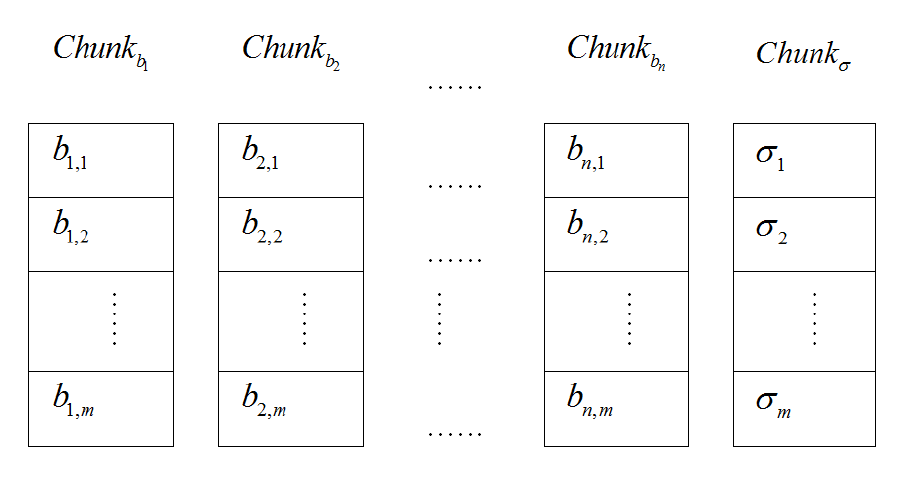
Figure 4. The storage distribution of evidence blocks and tags on the Chunk Storage Servers(CSS) in More Lightweight Proofs of Retrievability